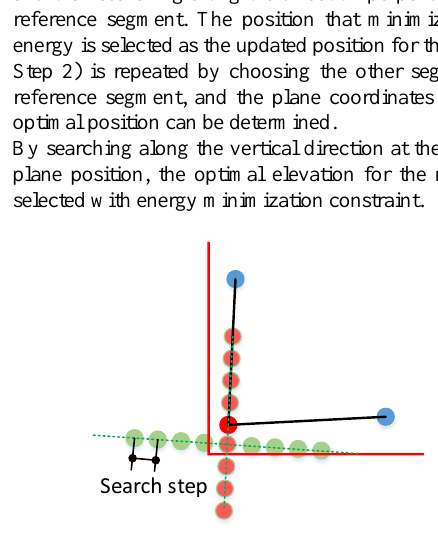
Figure 5. The search method for optimal position based on the reference segments. The black lines represent the initial contour, the red lines represent the actual contour. The red circle is the current position of the node, the green dashed lines are the search directions. The light red circles are the candidate positions when searching along the reference segment, the light green circles are the candidate positions when searching along the direction perpendicular to the reference segment.